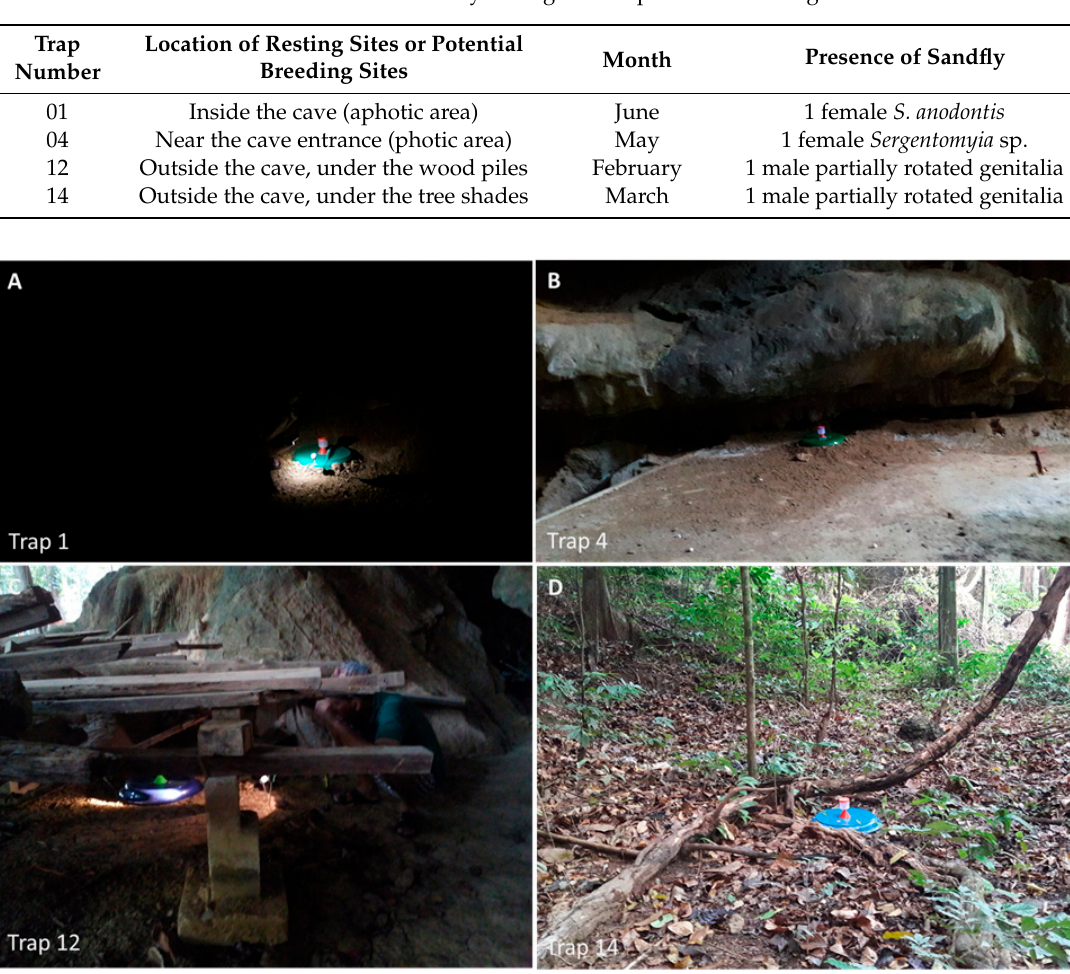
Table 4. Locations of sandfly resting sites or potential breeding sites.